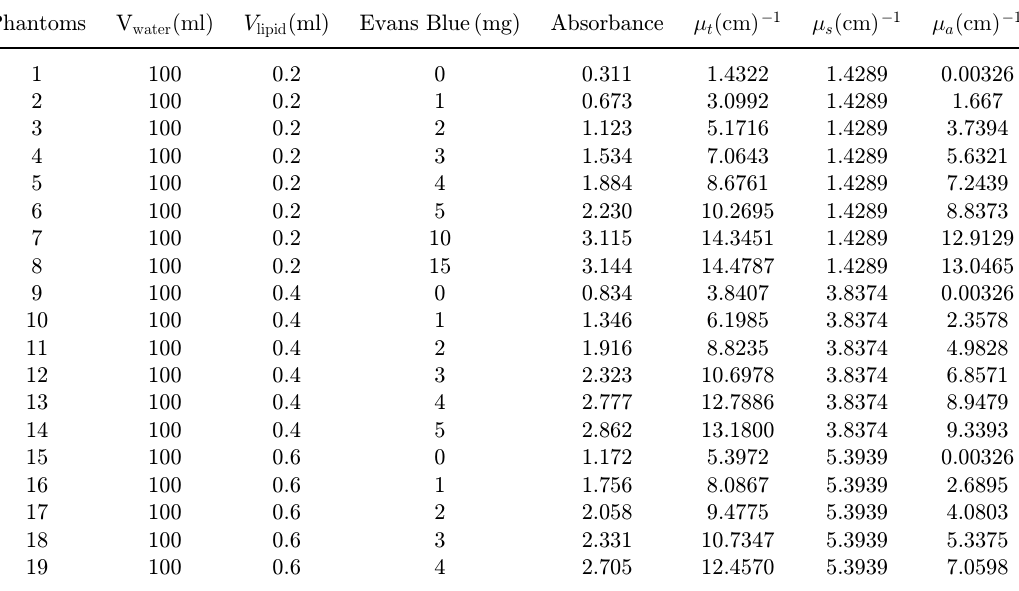
Table 1. Liquid Phantoms ( in vitro ) prepared for getting optical